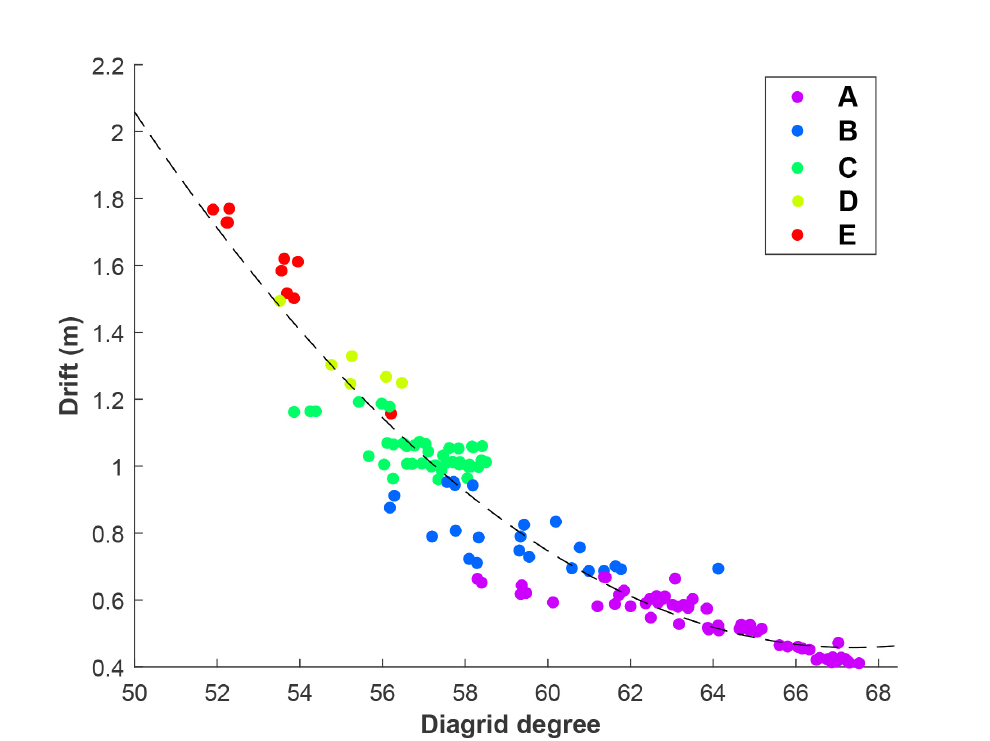
Figure 5. 5-class representation of the structural performance based on the drift and diagrid de- gree features.